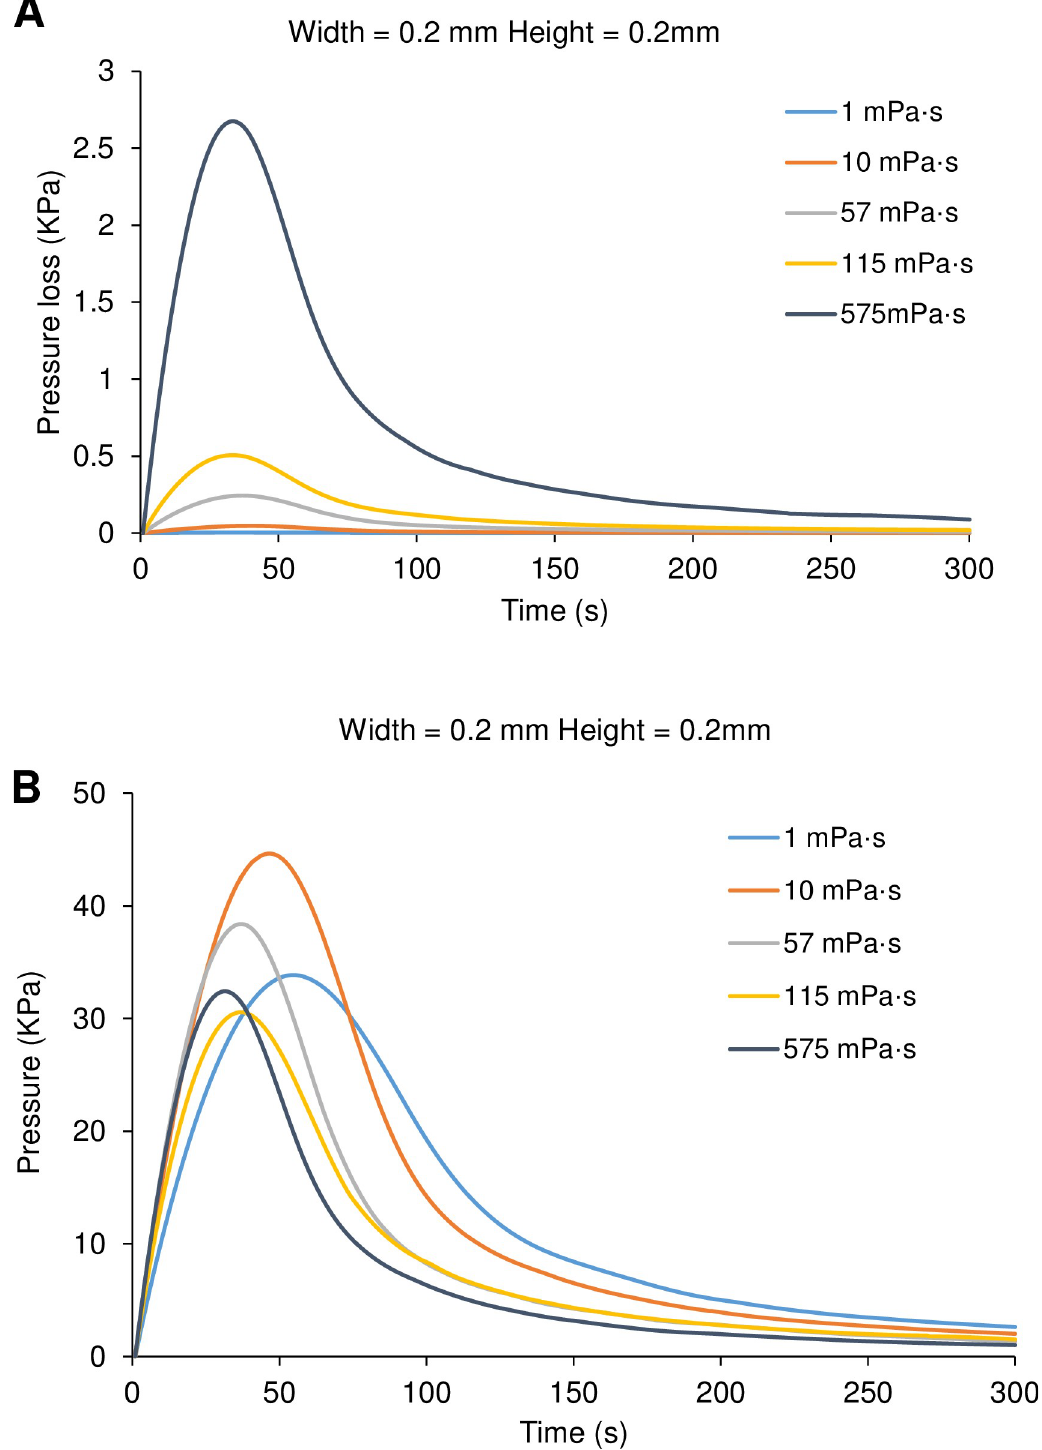
Fig 6. Pressure analysis of polyethylene glycol solution. (A) and (B) show estimated time-courses of pressure loss caused by viscosity and application time of the internal vacuum pressure, respectively (simulation results).